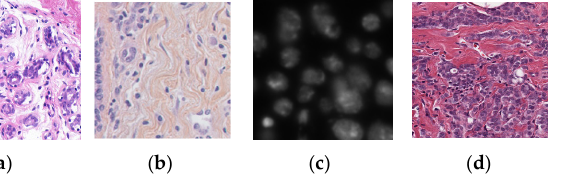
Figure 6. Sample images of four sub-datasets for segmentation: ( A ) UCSB; ( B ) TNBC; ( C ) 2018DSB; ( D ) MoNuSeg.